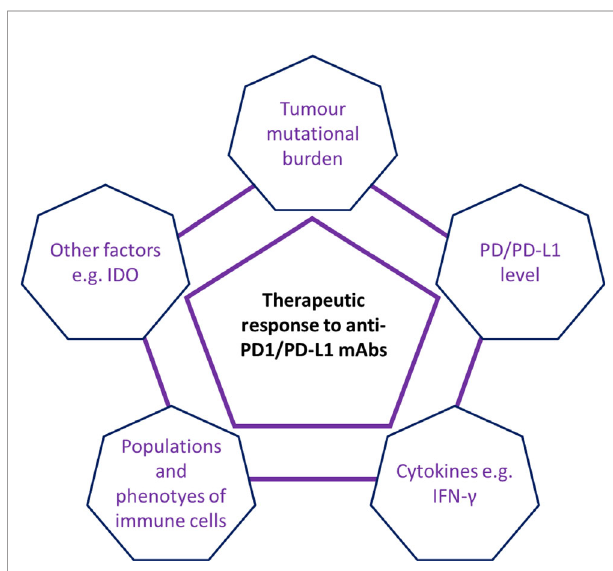
FIGURE 2 | Schematic summary of multiple factors involving in the anti-PD1/ PD-L1 therapeutic response in patients with CRC. Current evidence has suggested that multiple factors e.g. tumor mutational burden (TMB), IFN- g level, populations and phenotypes of immune cells and other factors ( e.g. immunosuppressive factors IDO) were involved in the regulation of anti-PD1/ PD-L1 therapeutic response in patients with